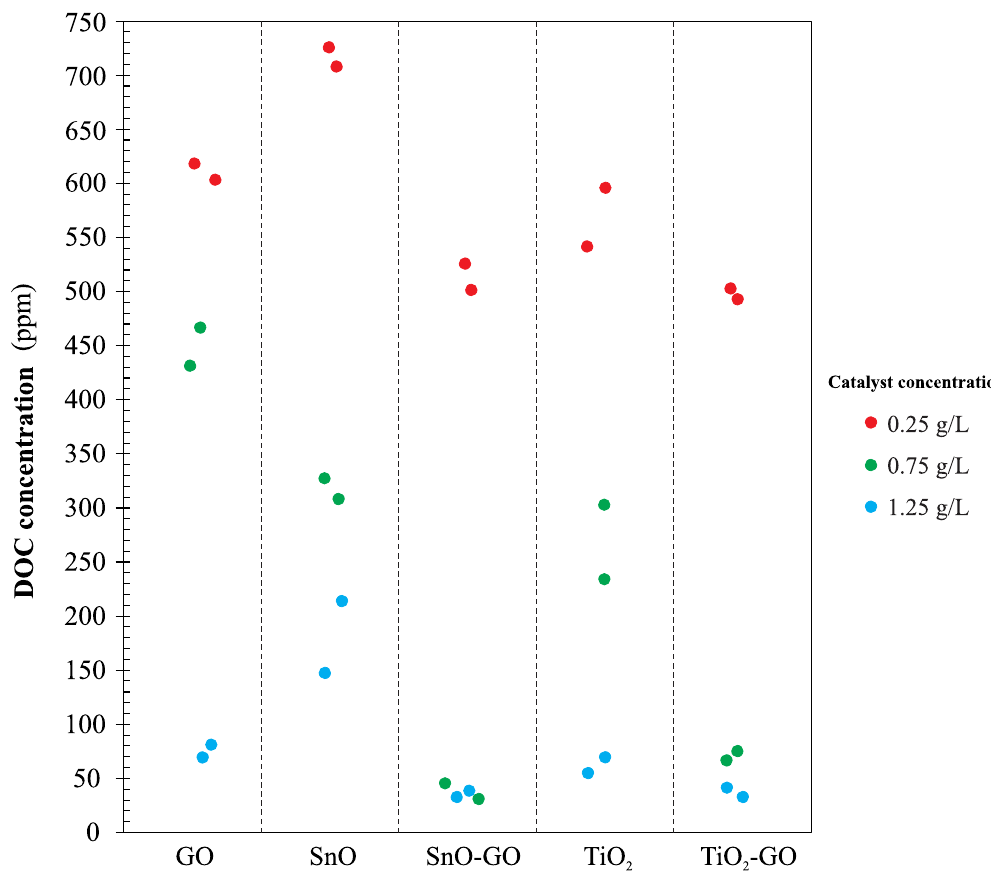
Figure 12. Concentration of DOC in the effluent after the photocatalytic treatment with each one of the catalysts the catalysts synthesized.